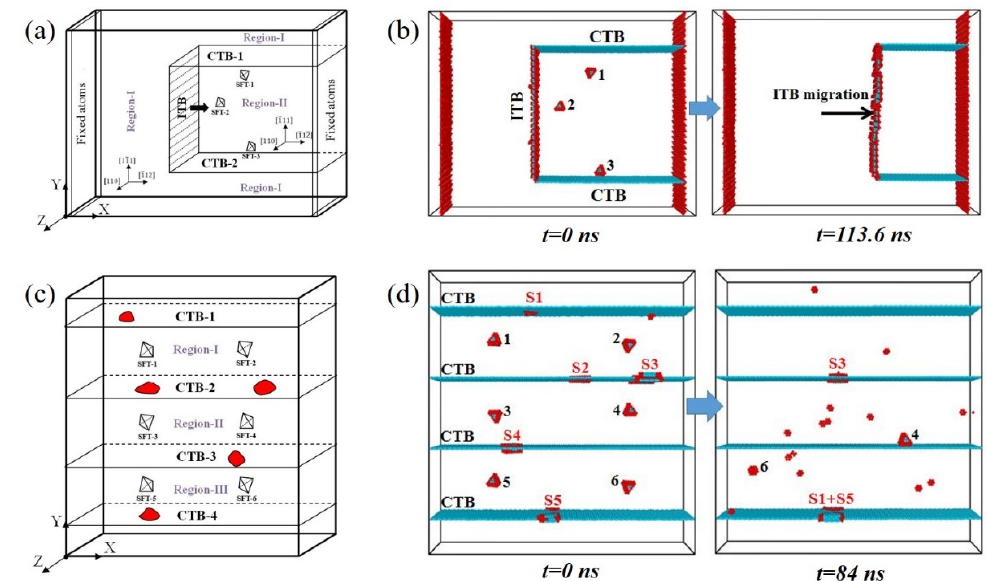
Figure 9. ( a ) Schematic of self-healing mechanism, based on incoherent twin boundary (ITB). ( b ) Interaction between migrating ITB and SFTs. ( c ) Schematic of self-healing mechanism, based on interstitial atoms segregation. ( d ) Interaction between SFTs and defective CTBs with interstitial atom clusters. Atoms are color coded according to their structures (cyan—HCP; red—other structure; FCC atoms not shown). Reproduced with permission from Ref. [91]. Copyright 2021 Clearance